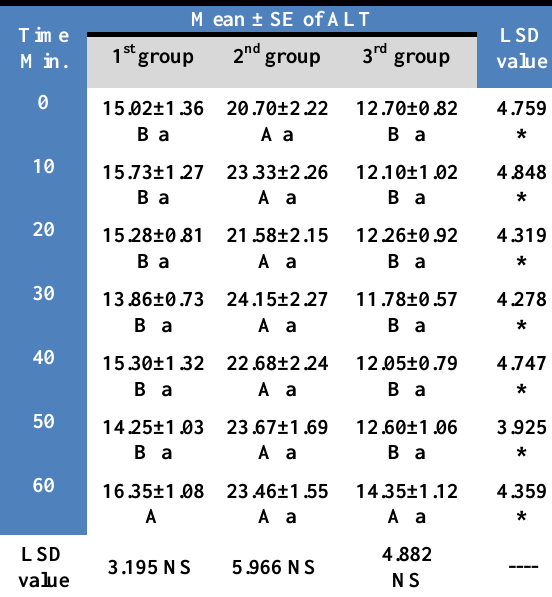
Table, 7: Show effect the treatment on the level of ALT.